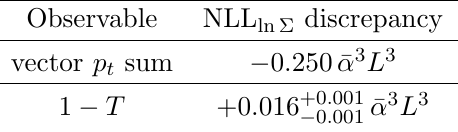
as elsewhere in s